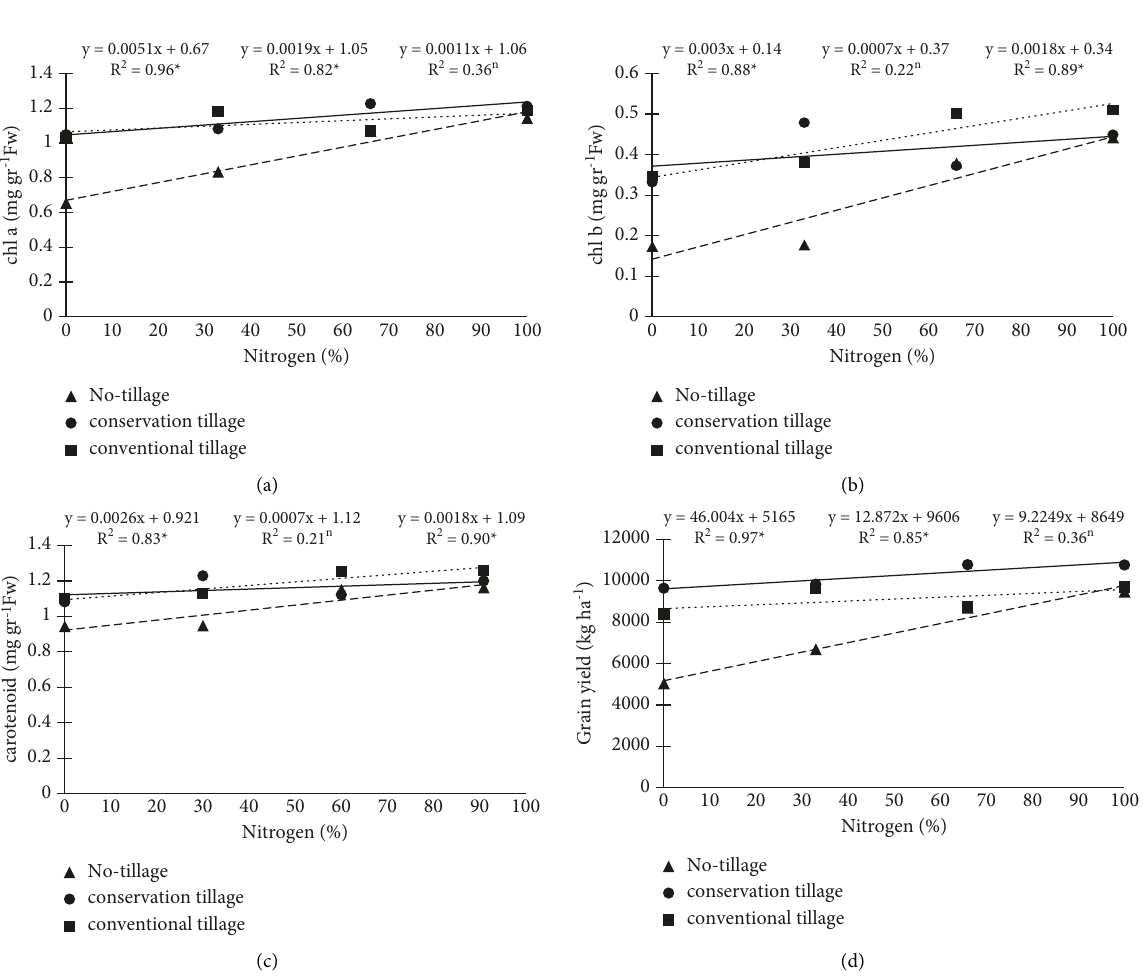
Figure 2: The trend of nitrogen fertilizer changes on chlorophyll a (a), chlorophyll b (b), carotenoids (c), and grain yield (d) of corn under tillage treatments.